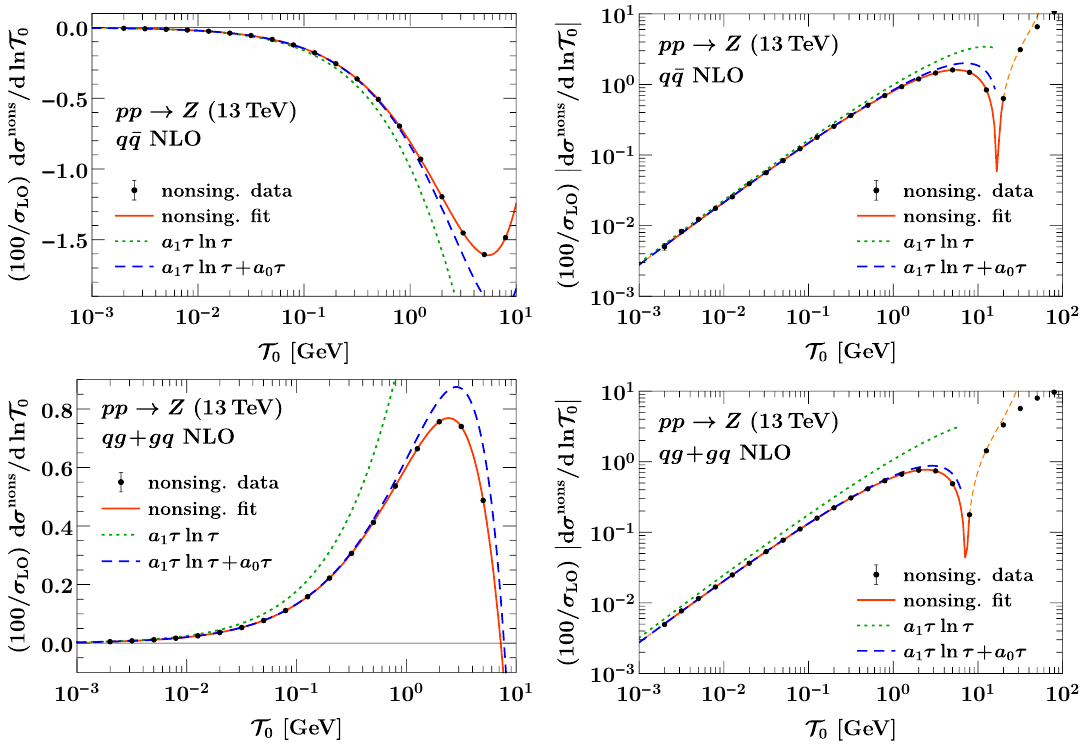
Figure 2 . The O ( (cid:11) s ) nonsingular corrections for Z production for the q (cid:22) q channel (top row) and the qg + gq channel (bottom row). A (cid:12)t to the nonsingular data is shown by the solid red curve. The LL and NLL results are shown by green dotted and blue dashed curves, respectively. In all cases, the NLL approximation provides an excellent approximation to the complete nonsingular cross